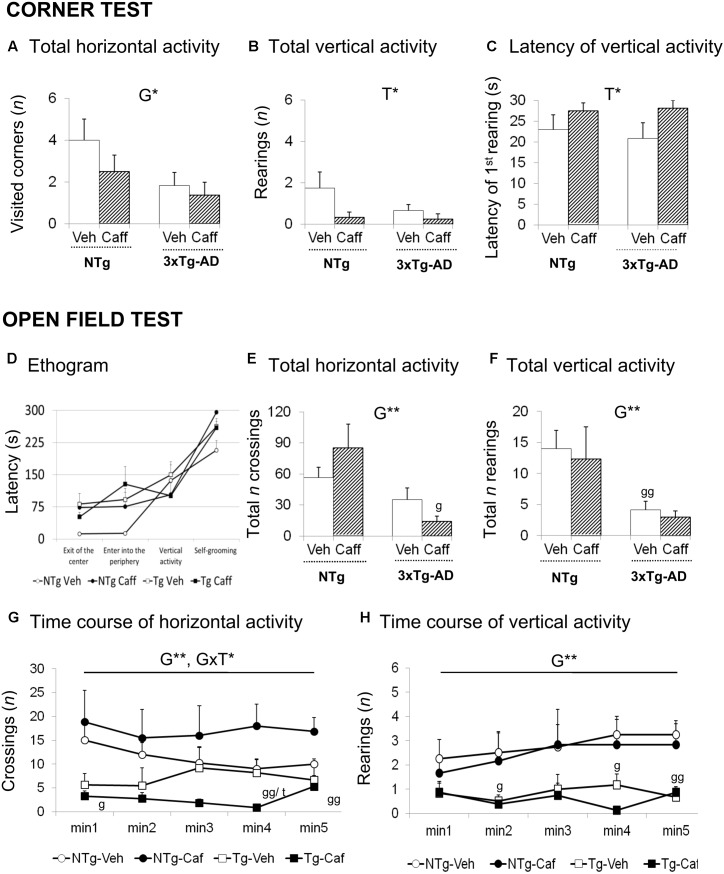
Effects of chronic caffeine treatment assessed in NTg and 3xTg-AD mice at 13-months of age in the corner (CT) and open-field (OF) tests. Horizontal (A) and vertical (B,C) activities in the corner test. Ethogram (D), horizontal (E,G), and vertical (F,H) activities in the OF test. Data are expressed by mean ± SEM. Veh, vehicle; Caff, caffeine. The text at the top of each graph refers to the p-values of the 2 × 2 ANOVA: G, genotype effect; T, treatment effect; GxT, genotype × treatment interaction; ∗p < 0.05, ∗∗p < 0.01, ∗∗∗p < 0.001. Post hoc comparisons are shown in the graphs as: g p < 0.05, gg p < 0.01 vs. the corresponding NTg group; ∗p < 0.05, ∗∗p < 0.01, ∗∗∗p < 0.001 vs. the corresponding non-treated group.